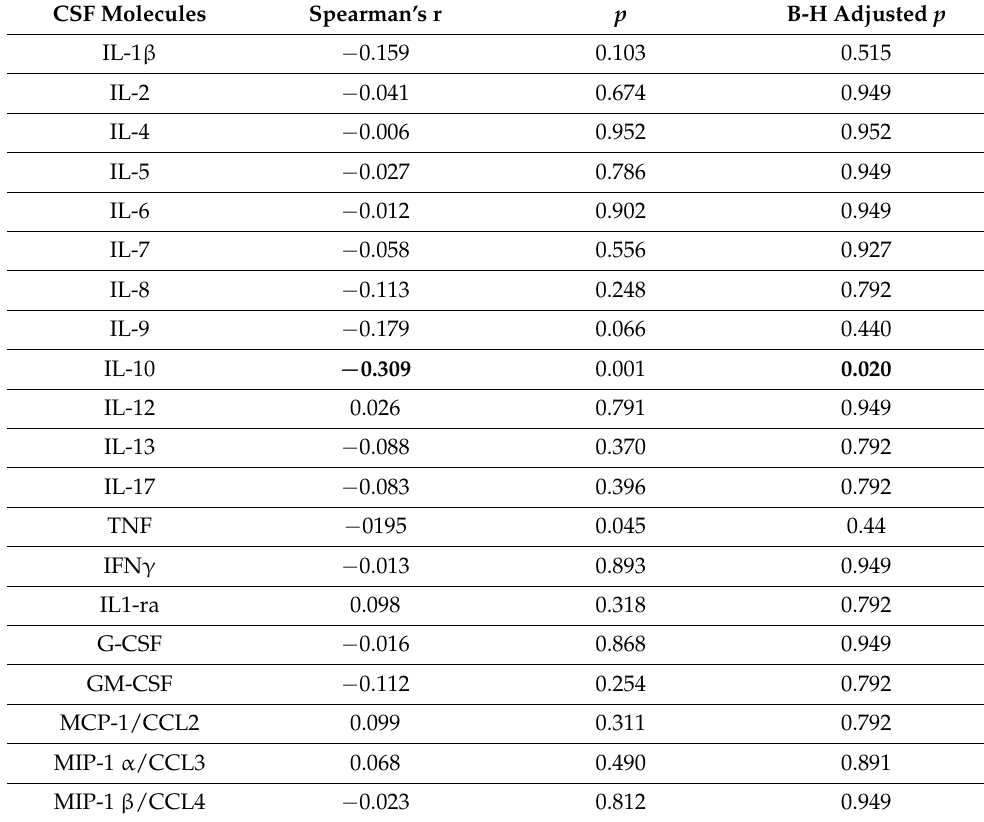
Table 2. Correlations between MFIS and CSF inflammatory molecules at MS diagnosis. CSF